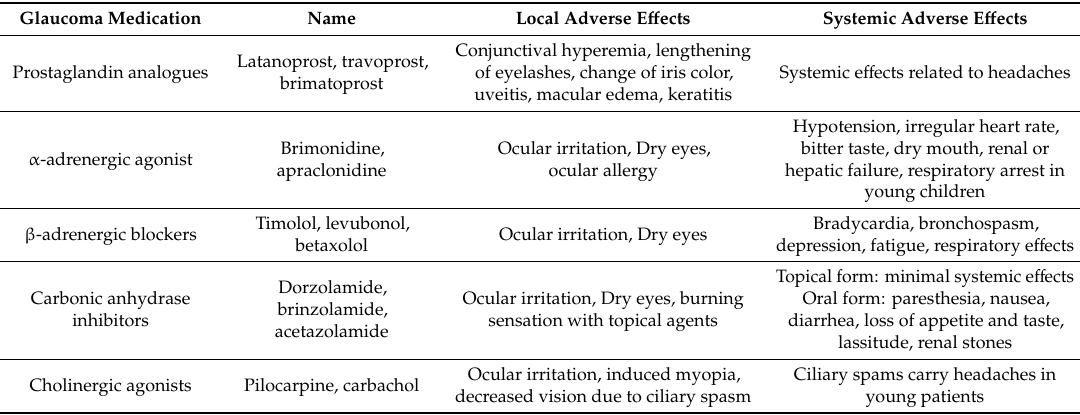
Table 1. Common adverse e ff ects associated to glaucoma